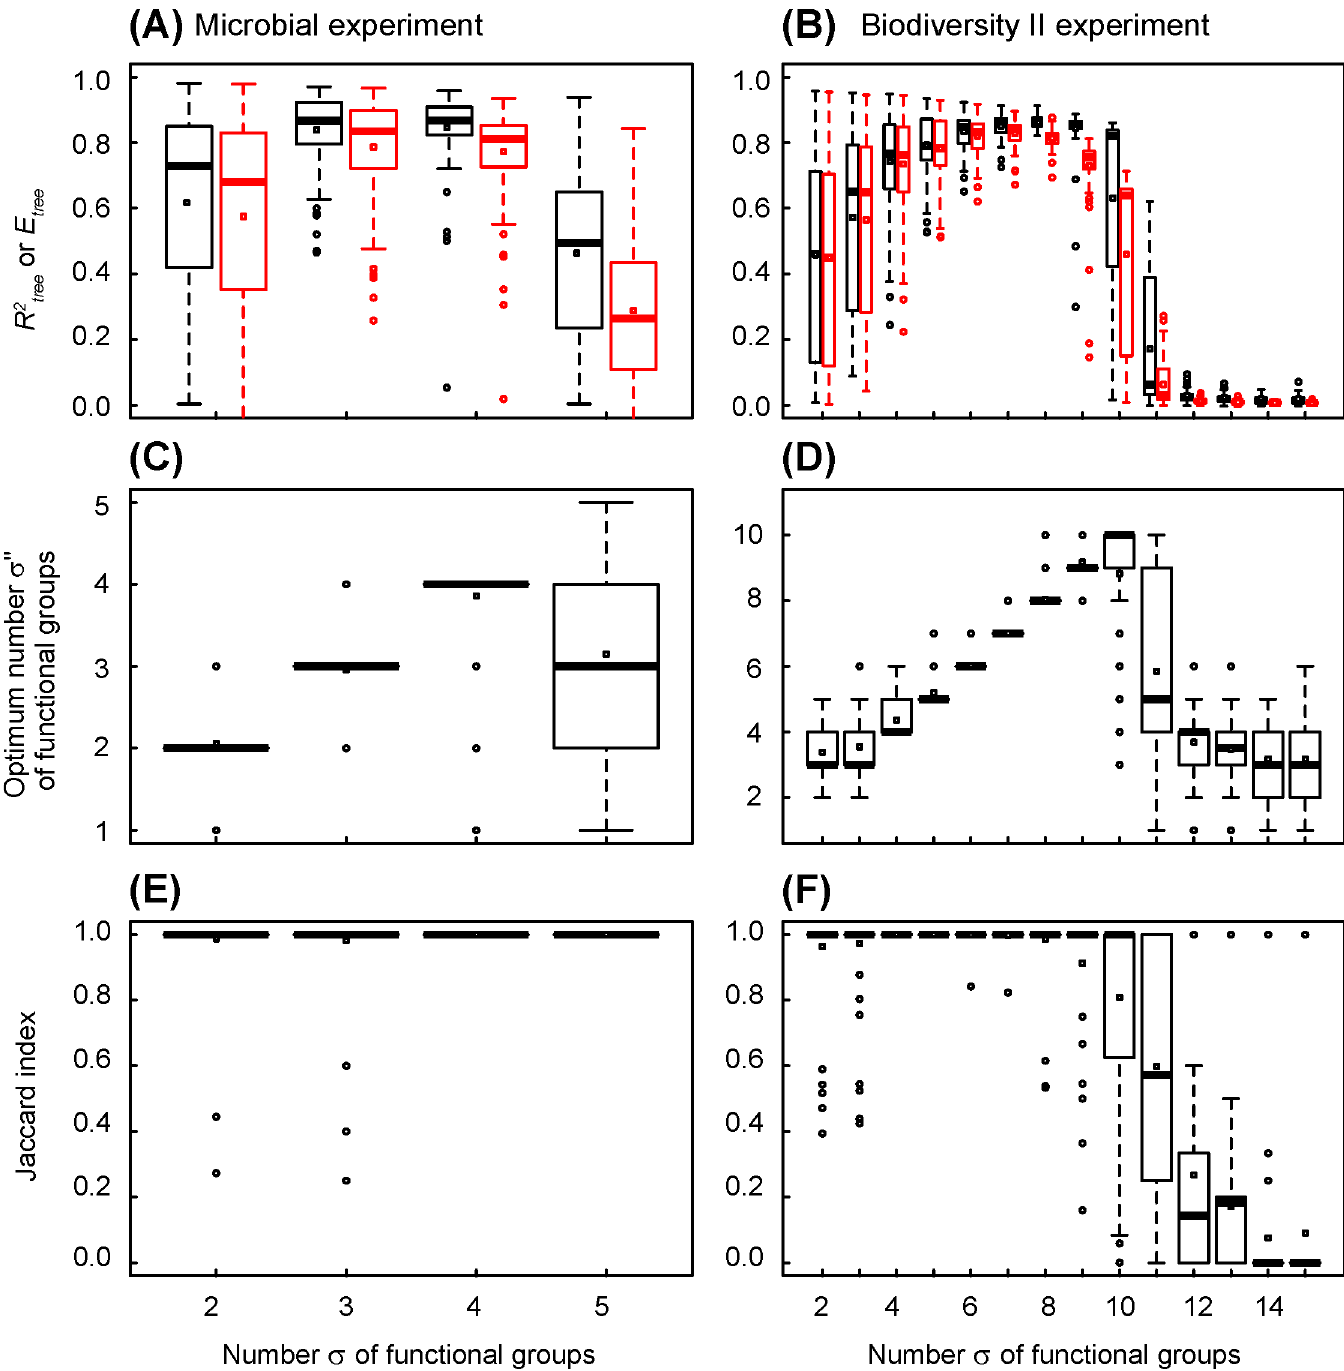
Fig 5. Changes in coefficient of determination, efficiency, optimum number of functional groups and Jaccard index in simulated datasets, versus relative error of ecosystem function and number of observed ecosystems. (A), (C) and (E) Simulated dataset mimicking the microbial experiment of Langenheder et al. [16]. All ecosystems are observed and the mean relative error increases from 0.02 to 1.28. The statistics describe 100 datasets randomly generated. (B), (D) and (F) Simulated dataset mimicking the Biodiversity II experiment of Tilman et al. [17]. The mean relative error is 0.17 and the number of observed ecosystems increases from 32 to 2048. The statistics describe 100 random sampling from a same random dataset. (A) and (B) Tree coefficient of determination (in black) and efficiency (in red). (C) and (D) Optimum number of functional groups indicated by tree AICc .(E) and (F) Jaccard index. In blue, by referring to the number of functional groups a priori defined (3 and 4 in microbial and Biodiversity II experiments, respectively). In red, by referring to 3 functional groups in Biodiversity II experiment, resulting from the clustering of the two largest species functional groups.